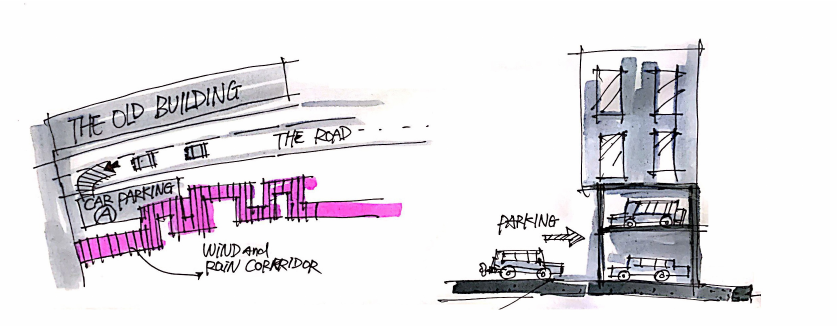
Fig. 6 Design of car park in Area A